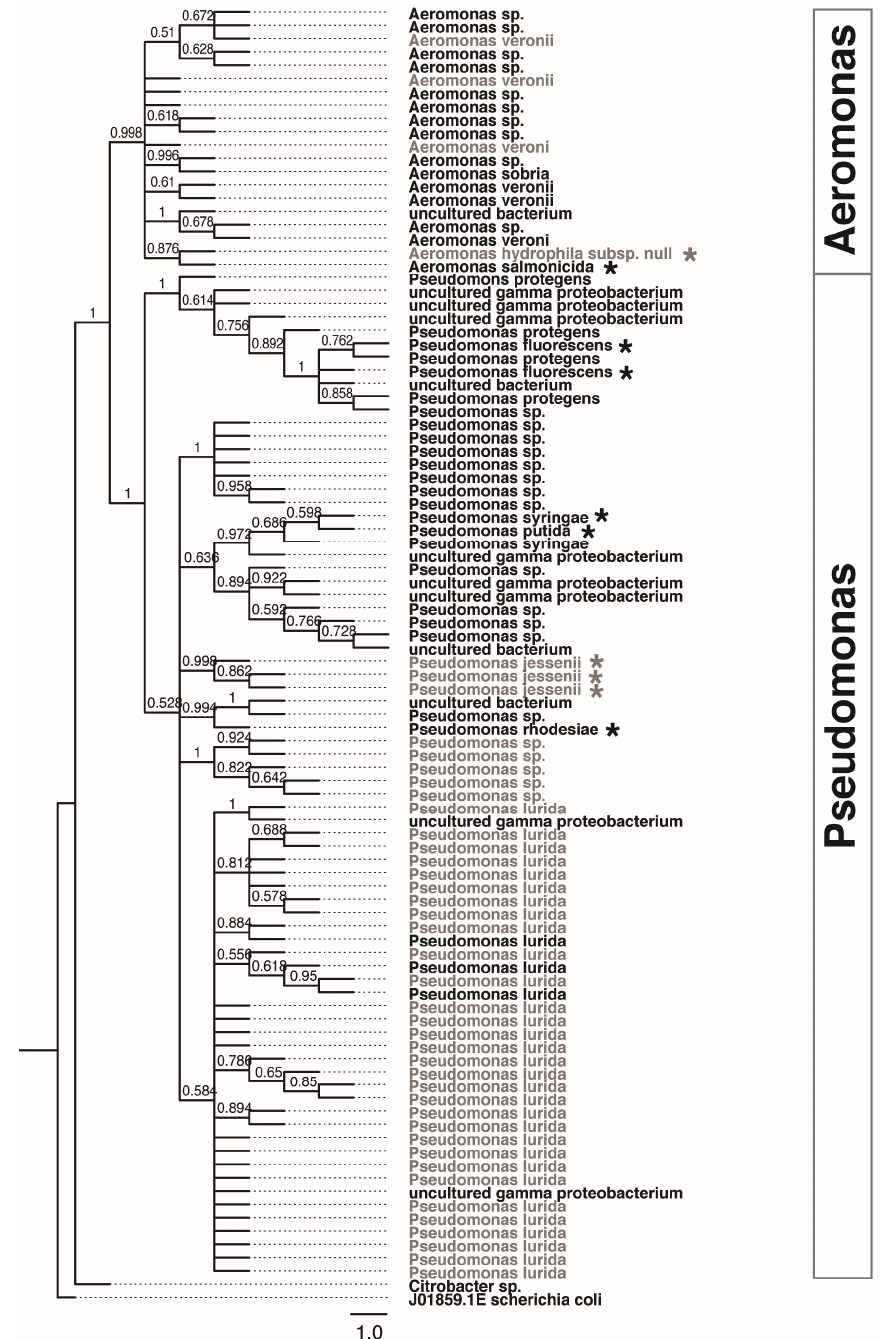
Figure 7. Distribution of protease-producing strains isolated from the gut of lake sturgeon fed different diet treatments. Larvae in control (CR) group were fed with live Artemia nauplii whereas treated (TR) group were fed with Artemia nauplii during the first 14 days post feedings (dpf) before transitioned to commercially grown bloodworm at 21 dpf. Isolates in bold text are microbial communities found larvae in the treated (TR) group and the remaining were from CR group. The maximum-likelihood phylogenetic tree was constructed using 16S rRNA sequence in MEGAX with general time reversible model and bootstrap support of 500 times. Protease-producers in both treatments were identified as Pseudomonas and Aeromonas with an isolate of Citrobacter sp. was identified in the control group. Pseudomonads and Aeromonads marked with an asterisk are species uniquely found in the TR group, and several are known to be associated with stress-related diseases in various fish species.